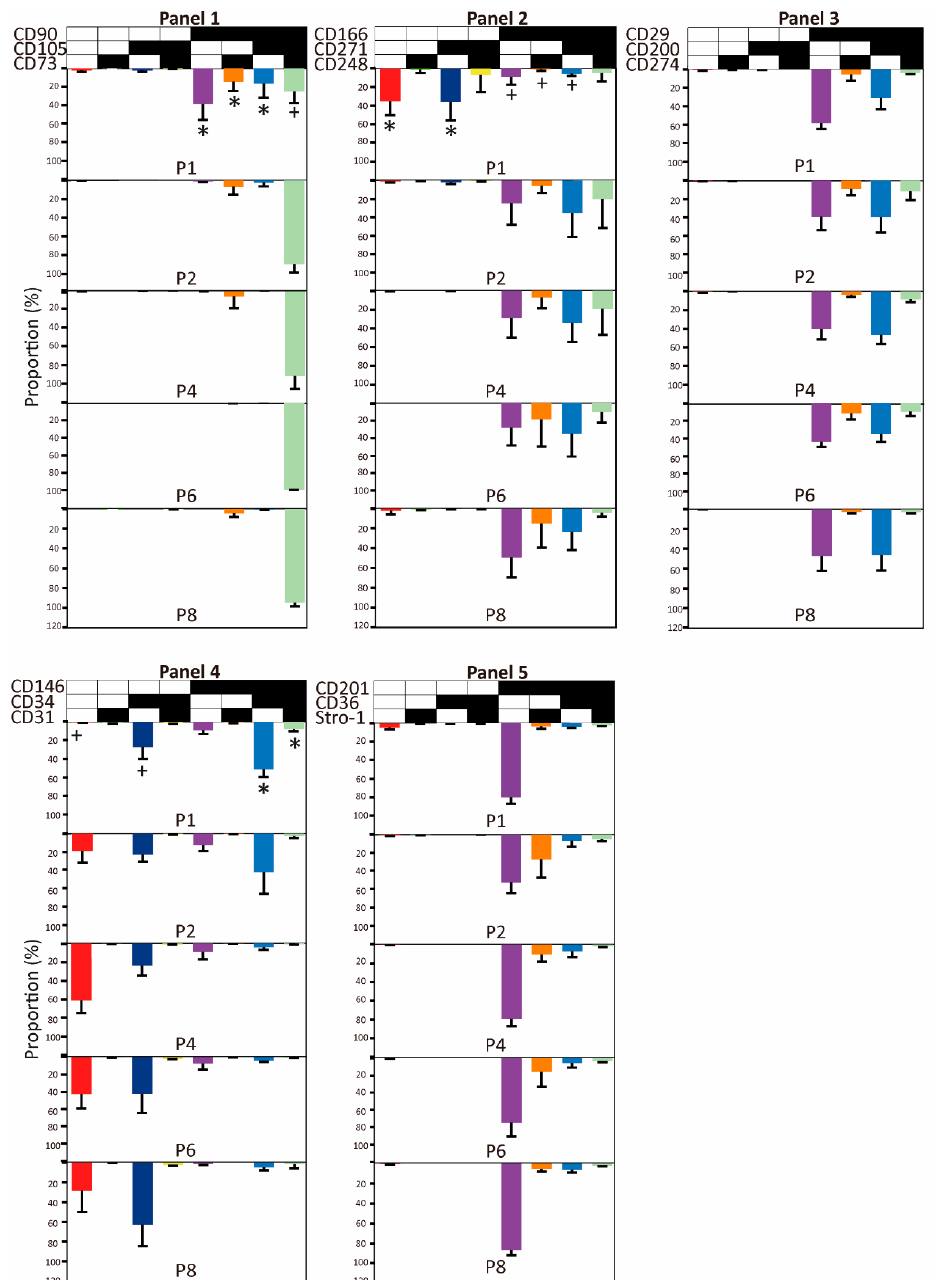
Figure 4. The prevalence of complex immunophenotypes within the functional panels and their temporal changes over eight passages. Panels: 1, mesenchymal stem cell (MSC) markers; 2, wound healing markers; 3, immune regulation markers; 4, Adipose-derived stromal/stem cell (ASC) markers, 5, differentiation capacity markers. A black field indicates that the marker was expressed; A white field indicates that the marker was not expressed. The data are presented as means + standard deviation, n = 7–8. *: population with the given combination of markers significantly decreases during culture. + : population with the given combination of markers significantly increases during culture. CD; cluster of di ff